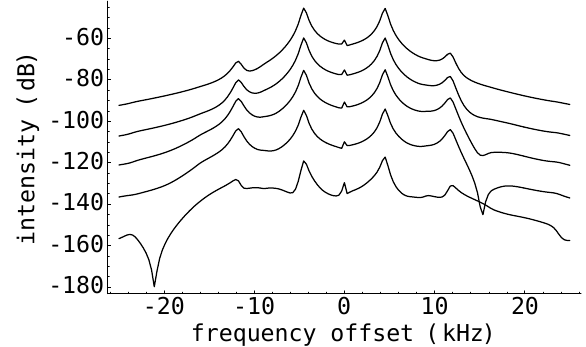
FIG. 12. Simulated beam response functions T 9 55 , T 18 55 , T 36 55 , T 55 55 , and T 135 55 (top to bottom) for a fully stretched 800 mA bunch in the VUV ring. Realistically detuned main- cavity and harmonic-cavity impedances are included in the simulation. The vertical scale has an arbitrary scale factor. Machine parameters are given in Table I.